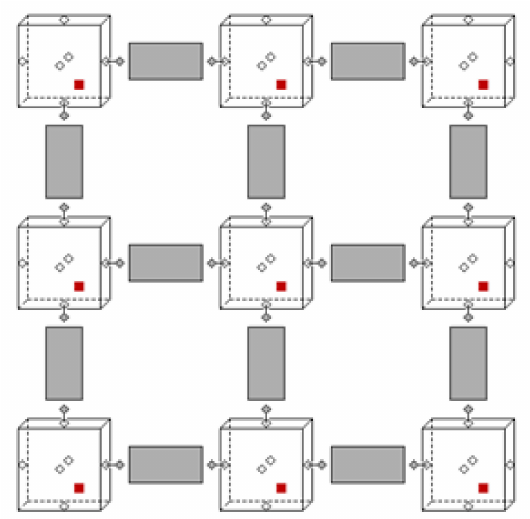
Figure 1. Schematic 2D representation of a zonal model: subdivision of the space into zones (cubes) connected by flow models